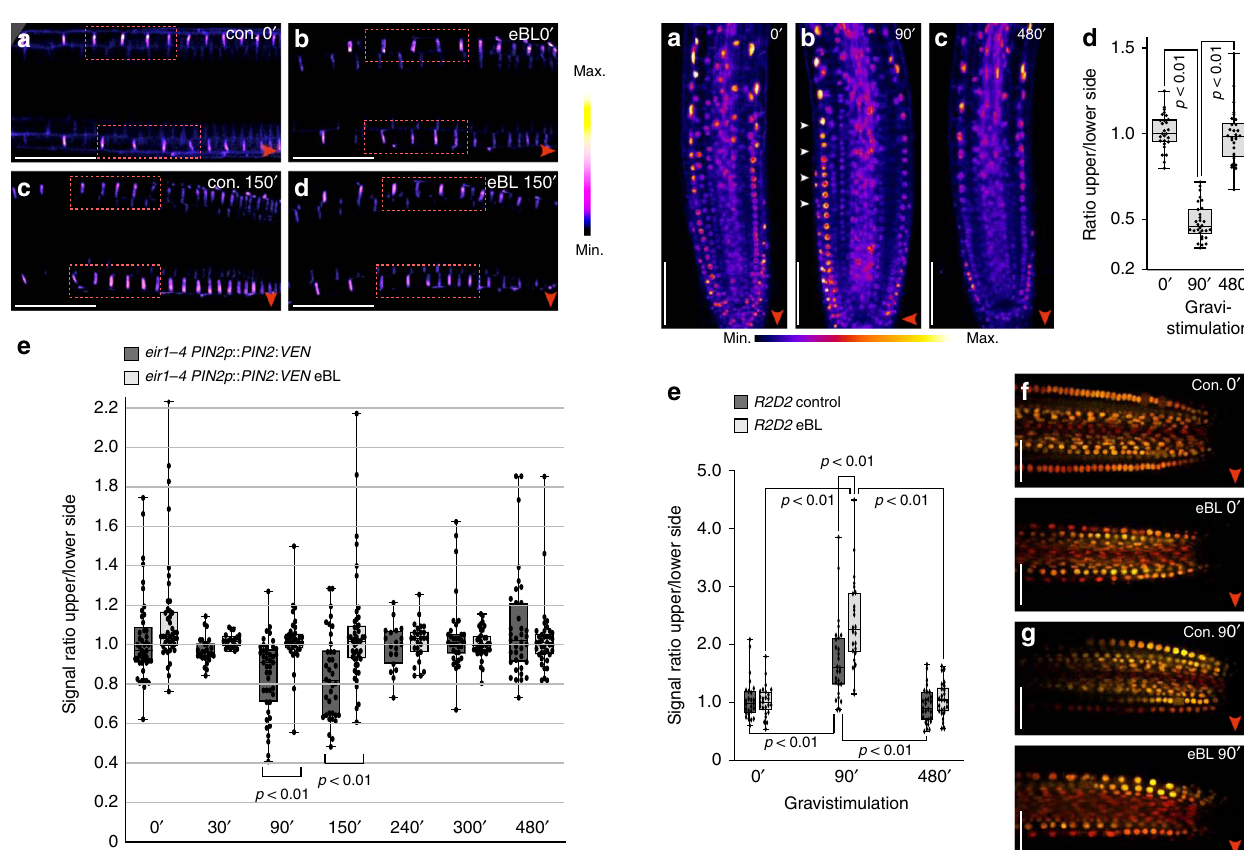
root is denoted by P lowerside and P upperside (Fig. 8a, b schemes, blue PIN2 PIN2 bars, Supplementary Fig. 11a). In the symmetrical (initial) state, there is no difference in permeabilities on both sides: ¼ P upperside ¼ P initial . The ratio of PIN2 permeabilities P lowerside PIN2 PIN2 PIN2 is assumed proportional to the measured PIN2:VEN signal ratio, upperside ¼ PIN2 : Venussignalupperside ¼ k . We as presented in Fig. 6e: P PIN2 PIN2 : Venussignallowerside P lowerside PIN2 used this ratio, denoted as parameter k , to de fi ne permeabilities as